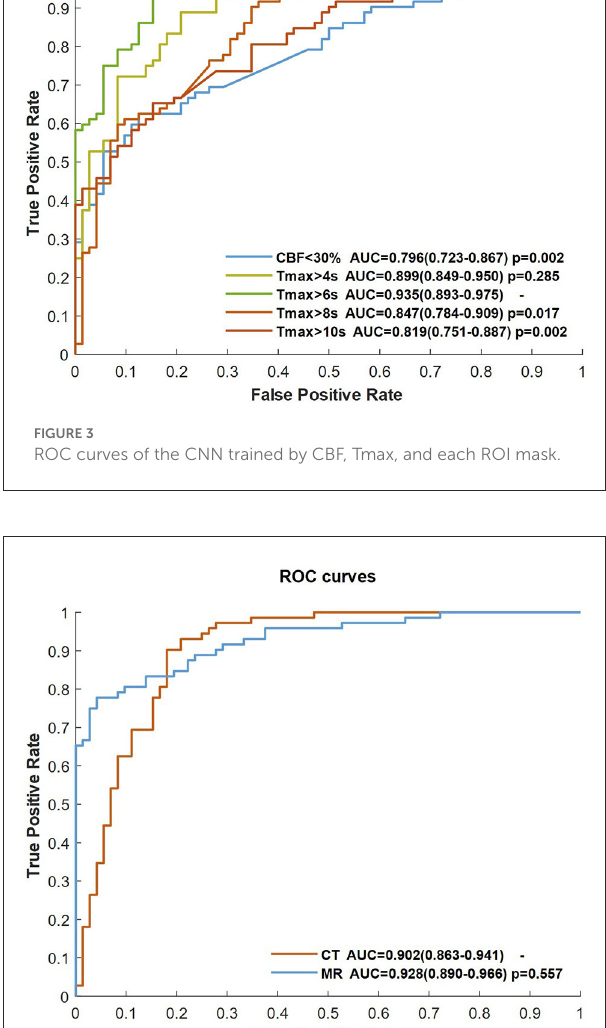
of two groups. The AUCs of the two groups were higher than 0.9, and there was no significant difference between them ( p =